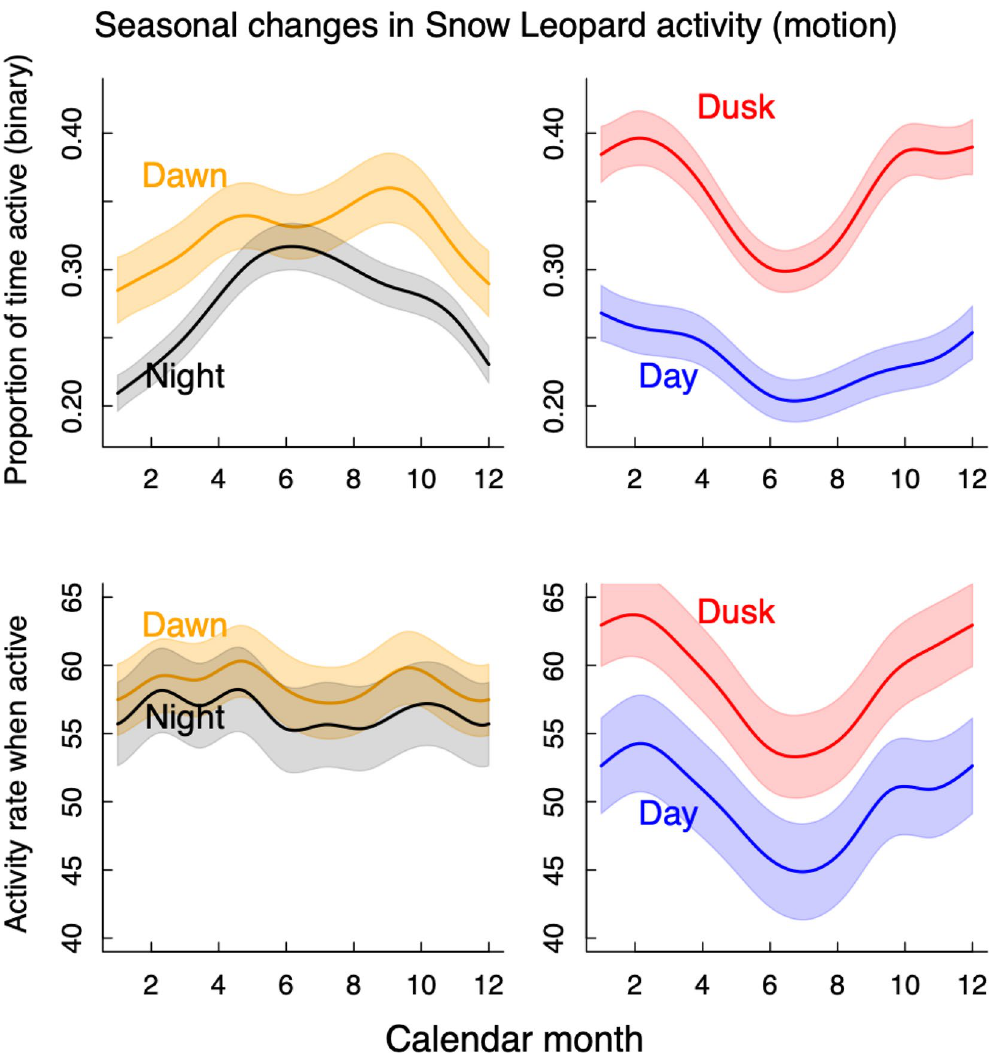
Figure 5. Prediction plots from GAMMs examining variation in snow leopard accelerometer (motion) activity relative to the calendar month for four specific periods during the 24-h cycle: night (black), dawn (yellow), day (blue) and dusk (red). The top two panels show the proportion of total time spent active, and the lower two panels show the activity rate when active. Plots show means (lines) ± SE (shaded areas) generated from the individual